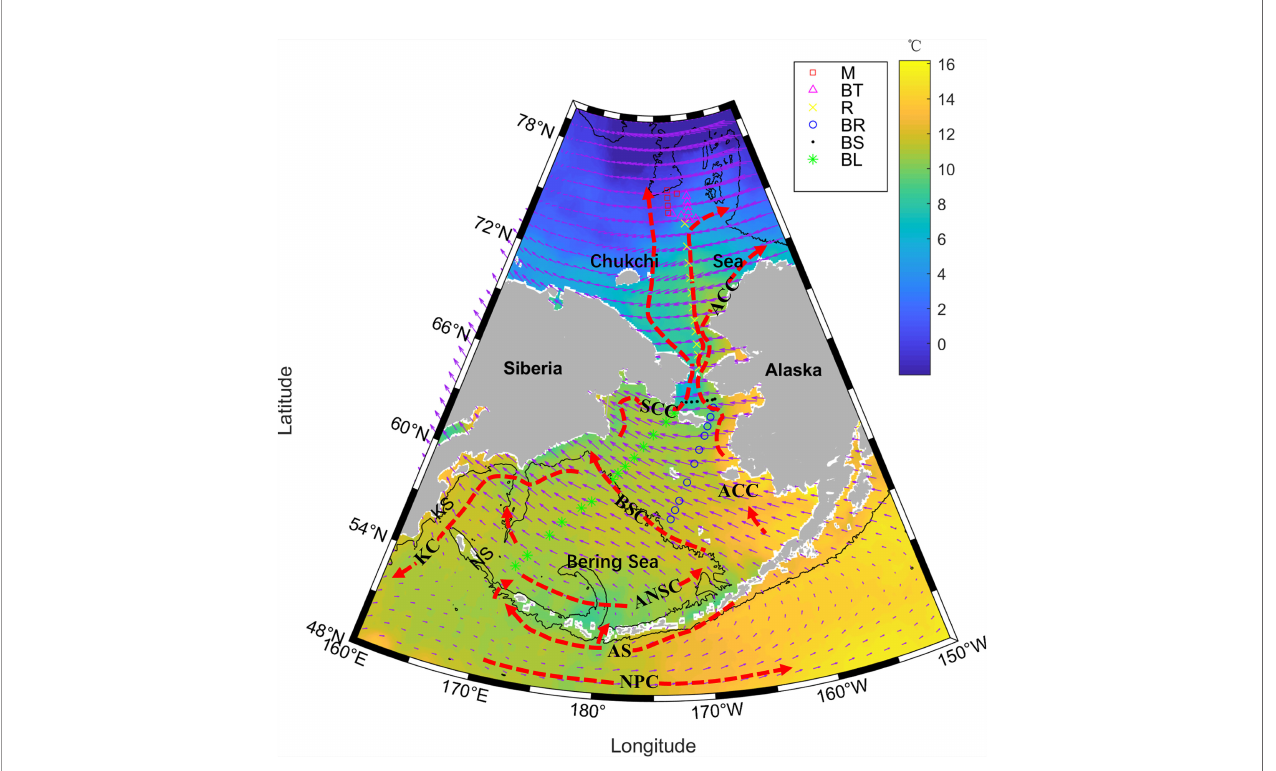
FIGURE 1 | The distribution of 58 observation stations and patterns of major circulations in the study area. The asterisks, dots, circles, crosses, triangles, and squares represent the BL, BS, BR, R, BT, and M sections, respectively. The color denotes the mean sea surface temperature during the expedition. The arrows were the wind during the expedition. The black solid lines denote 2000-m isobaths. ACC, Alaskan Coastal Current; SCC, Siberian Coastal Current; KC, Kamchatka Current; BSC, Bering Slope Current; ANSC, Aleutian North Slope Current; AS, Alaskan Stream; NPC, North Paci fi c Current; KS, Kamchatka Strait; NS, Near Strait (Danielson et al., 2014; Gong and Pickart, 2015; Stabeno et al.,